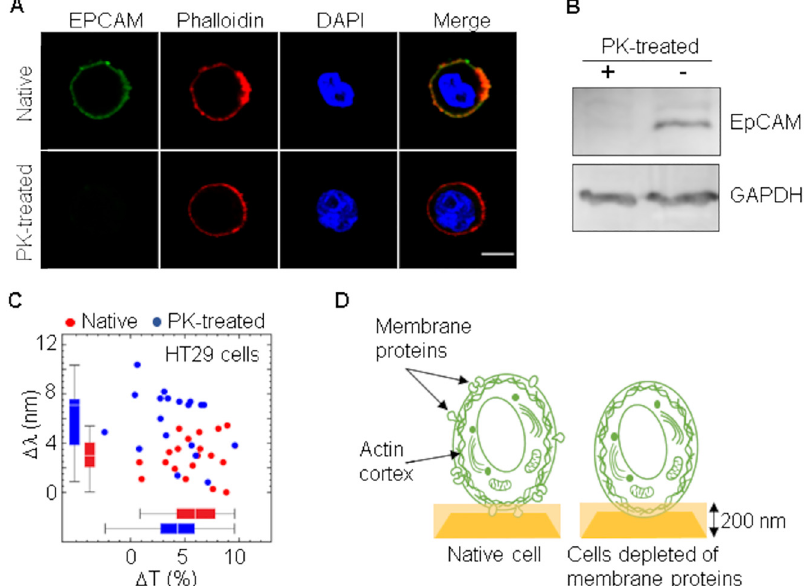
Figure 6: Spectral changes in cells depleted of membrane proteins. (A) HT29 cells were treated with 1 mg/mL proteinase K for 1 h at 37 ° C and then fi xed with 4% paraformaldehyde for immuno fl uorescence stainingof EPCAMandactin cortex(phalloidin). DAPIwasused to labelnuclei.Scalebar:5 μ m.(B)Total proteinwas extractedfromHT29 cells following incubation with proteinase K and analyzed by western blot using an anti-EPCAM antibody. Housekeeping protein GAPDH was also analyzedto assureequalloading.(C) Spectralshiftandchangeintransmittanceof cells afterdepletionof membraneproteins.Thresholdwas set to 3.8 nm and sensitivity (70%) and speci fi city (79%) were determined. (D) Schematic representation of a cell deposited on a nanohole array with and without membrane proteins. Plasmon depth of 200 nm is